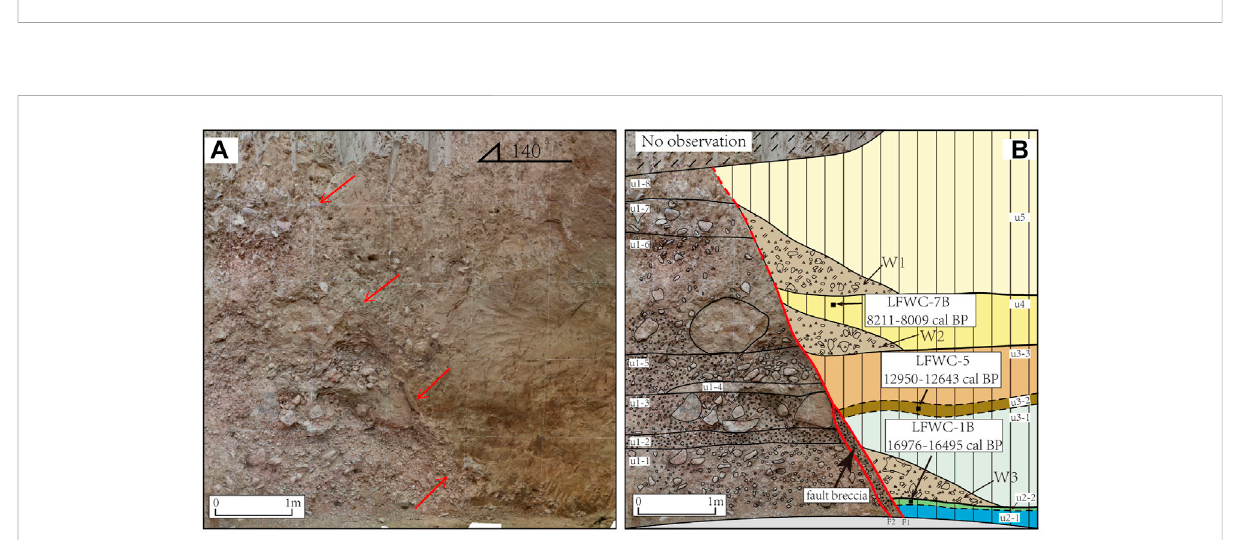
FIGURE 9 Photograph mosaic (A) and the interpreted map (B) of the Luofengwa pro fi le. U denotes stratum unit, and black lines show the stratigraphic contacts between units or subunits. Red lines show the fault planes. Small black fi lled squares show the locations of radiocarbon samples, labeled with sample numbers and their ages (Table